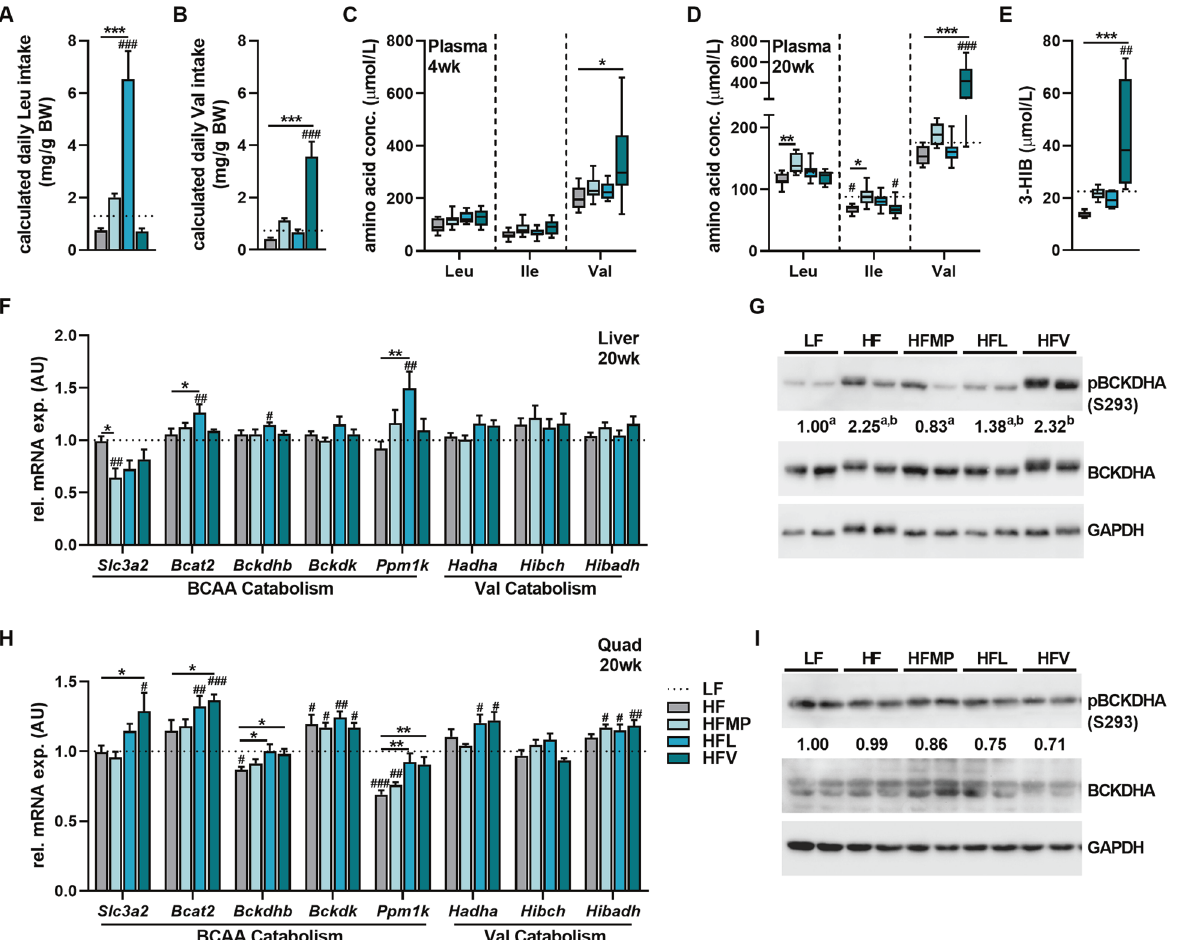
Fig. 3 Accumulation of valine and its metabolite 3-hydroxyisobutyrate after valine supplementation. A Calculated daily Leu intake for male C57BL/6 JRj mice fed low-fat (LF), high-fat (HF), or experimental HF diets supplemented with milk protein (HFMP), leucine (HFL), or valine (HFV) for 20 weeks ( n = 8). B Calculated daily Val intake ( n = 8). C Two-hour fasting plasma BCAA levels after 4 weeks ( n = 8). D 2 h fasting plasma BCAA levels after 20 weeks ( n = 8). E Two-hour fasting plasma 3-hydroxyisobutyrate (3-HIB) levels at 20 weeks ( n = 6). F qPCR of key genes in BCAA oxidation normalized to LF in liver at 20 weeks with B2m as reference gene ( n = 8). G Representative western blot of BCKDHA phosphorylation in liver normalized to LF ( n = 6). H qPCR of key genes in BCAA oxidation normalized to LF in quadriceps (quad) muscle at 20 weeks with B2m as reference gene ( n = 8). I Representative western blot of BCKDHA phosphorylation in quad normalized to LF ( n = 6). Plasma data ( C – E ) are expressed as interleaved box and whiskers (min to max) plots. All other data are shown as mean + SEM except for western blot quanti fi cation where only mean is indicated below representative blots. LF is represented as dotted line. * p < 0.05; ** p < 0.01; *** p < 0.001 compared to HF and # p < 0.05; ## p < 0.01; ### p < 0.001 compared to LF. Different letters represent signi fi cant difference between groups in Western blots. BCAA branched-chain amino acids, FA fatty